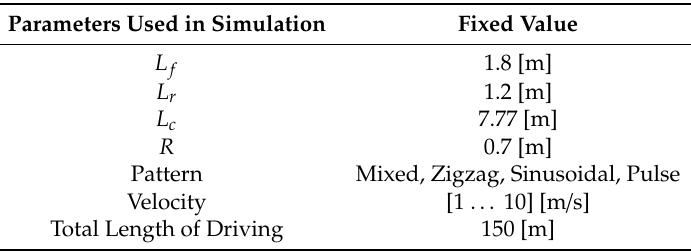
Table 5. Simulation study cases and parameter values.